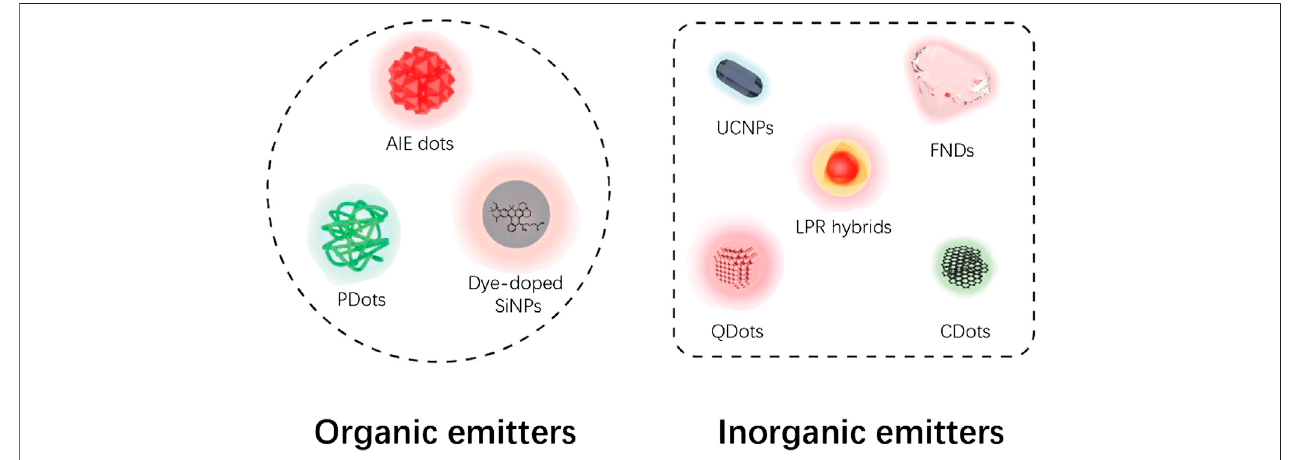
FIGURE 2 | Categories of STED nanoprobes based on current report. Note that dye-doped SiNPs were classi fi ed as organic emitters based on their molecular fl uorescence origin.